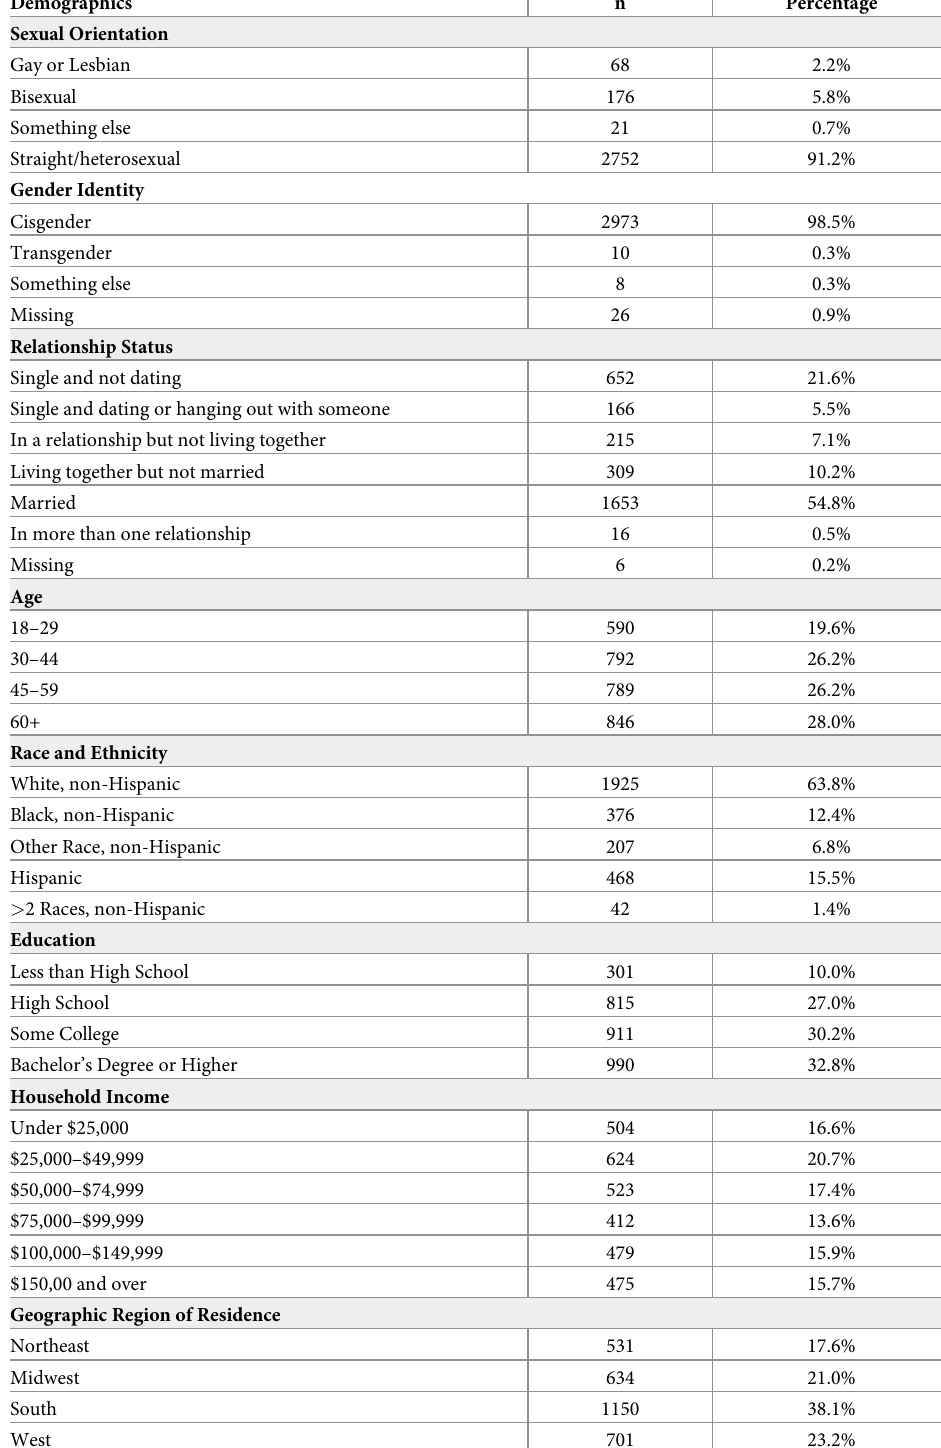
Table 1. Demographics of national probability sample of 3017 U.S. women